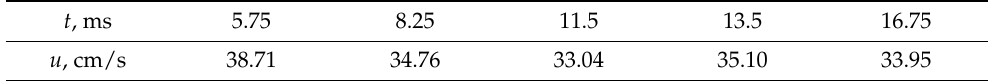
Table 1. Speed of the inner boundary of the annular capillary wave domain